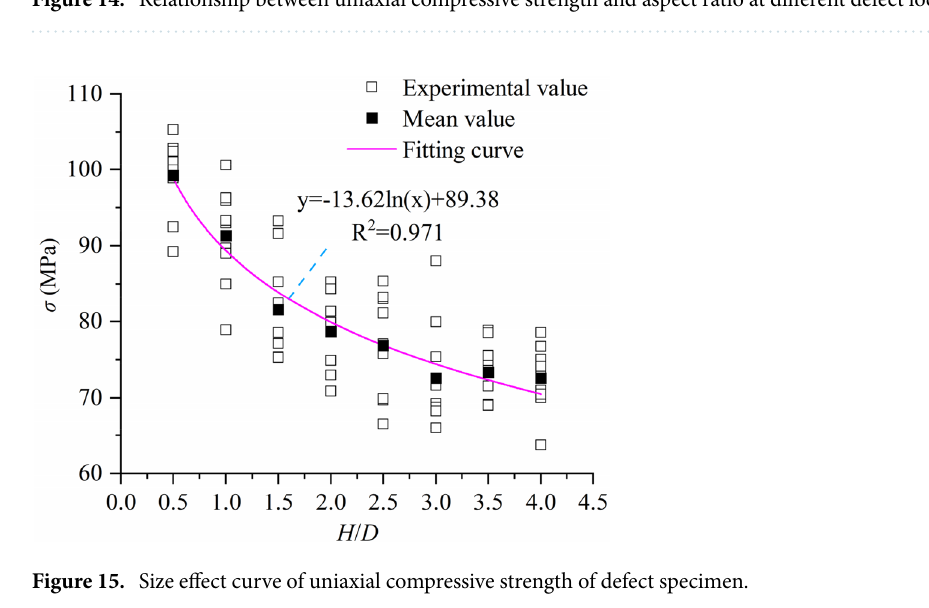
Figure 14. Relationship between uniaxial compressive strength and aspect ratio at different defect locations.